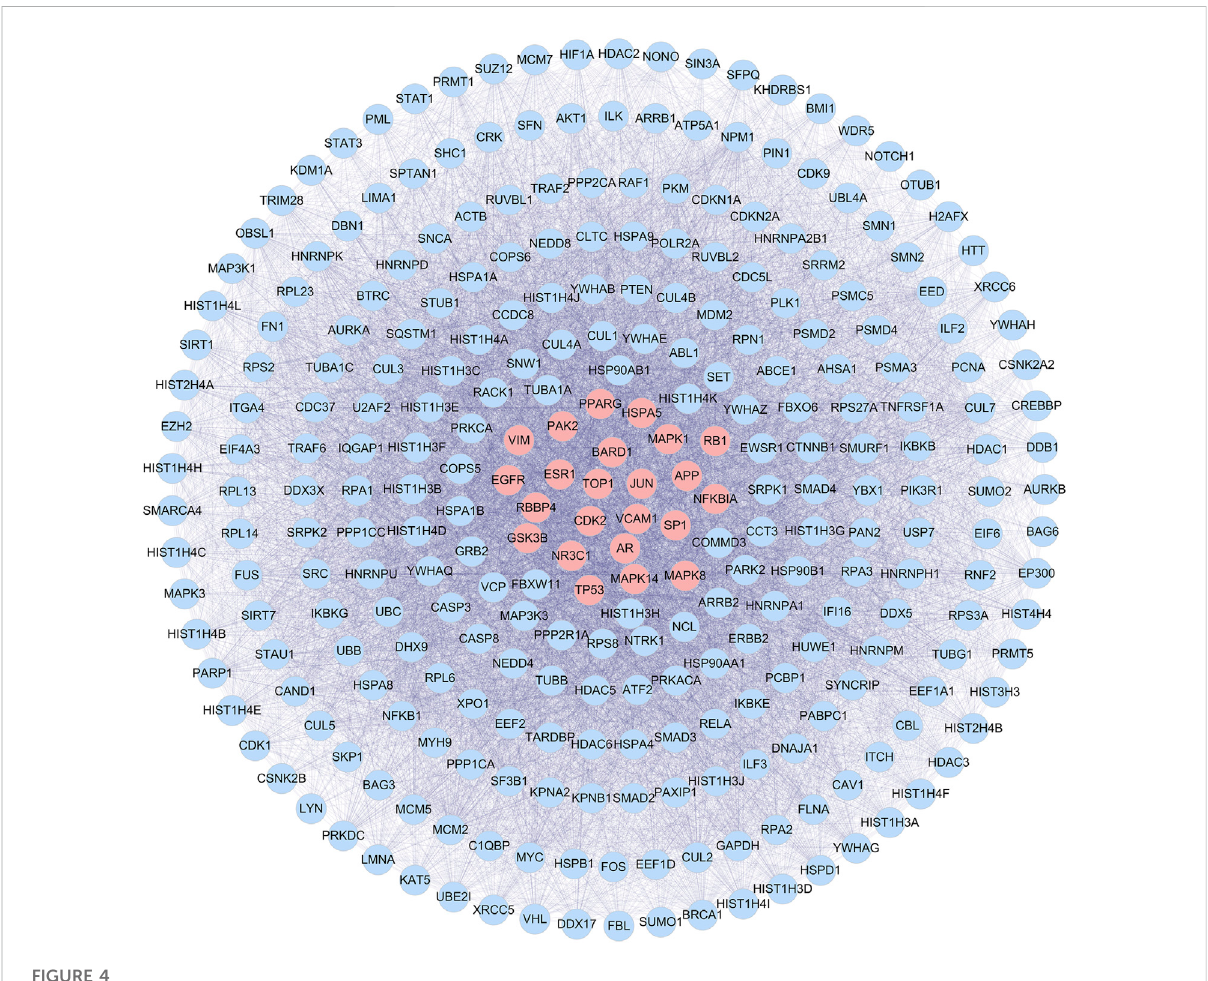
FIGURE 4 PPI network of candidate targets of CGGE against